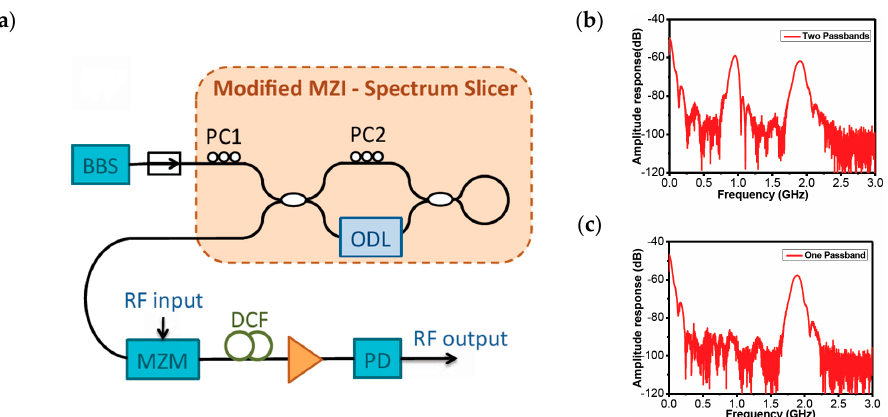
Figure 2. ( a ) Schematic diagram of the reconfigurable and tunable dual-band microwave photonic